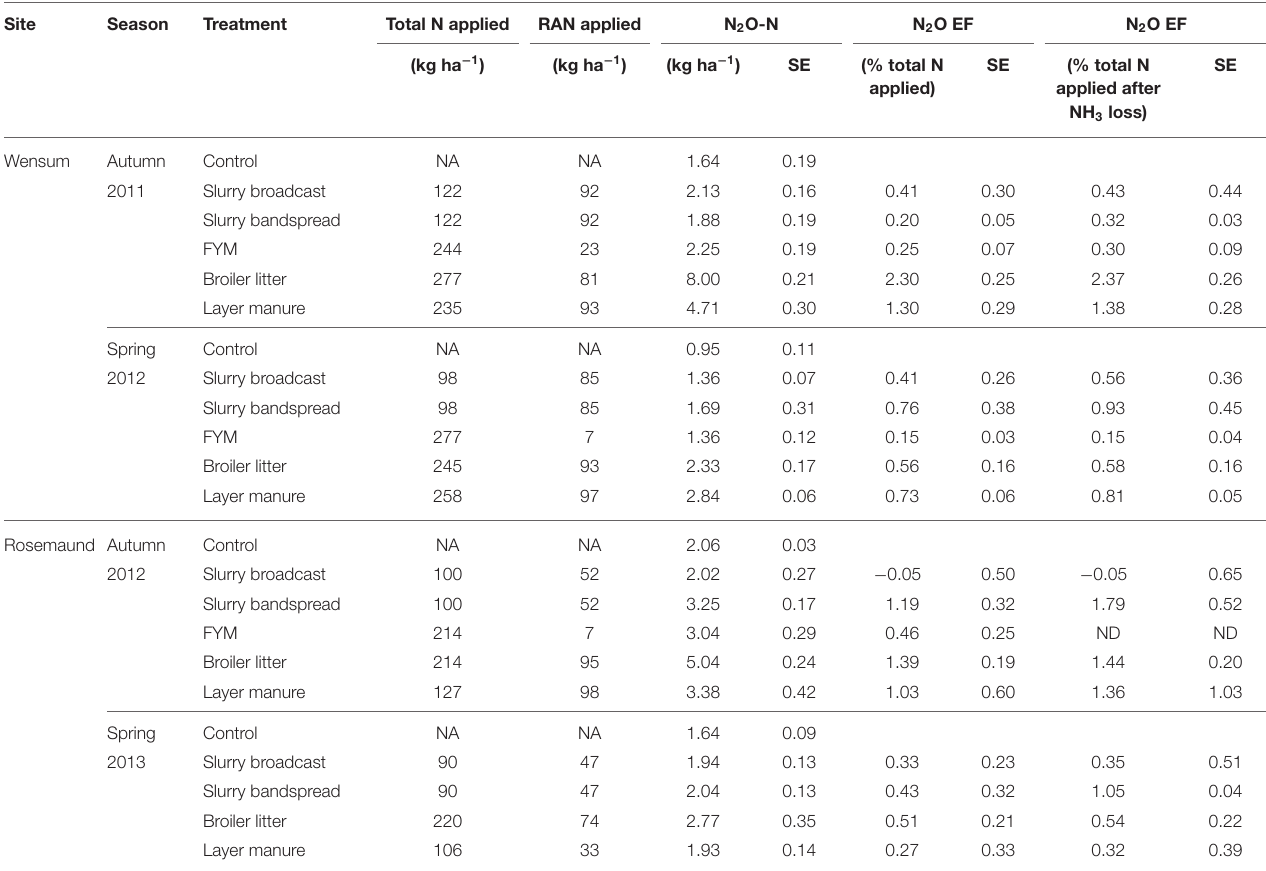
TABLE 8 | Manure nitrogen applied, mean annual N 2 O emissions and emission factors (EFs) at the arable sites.